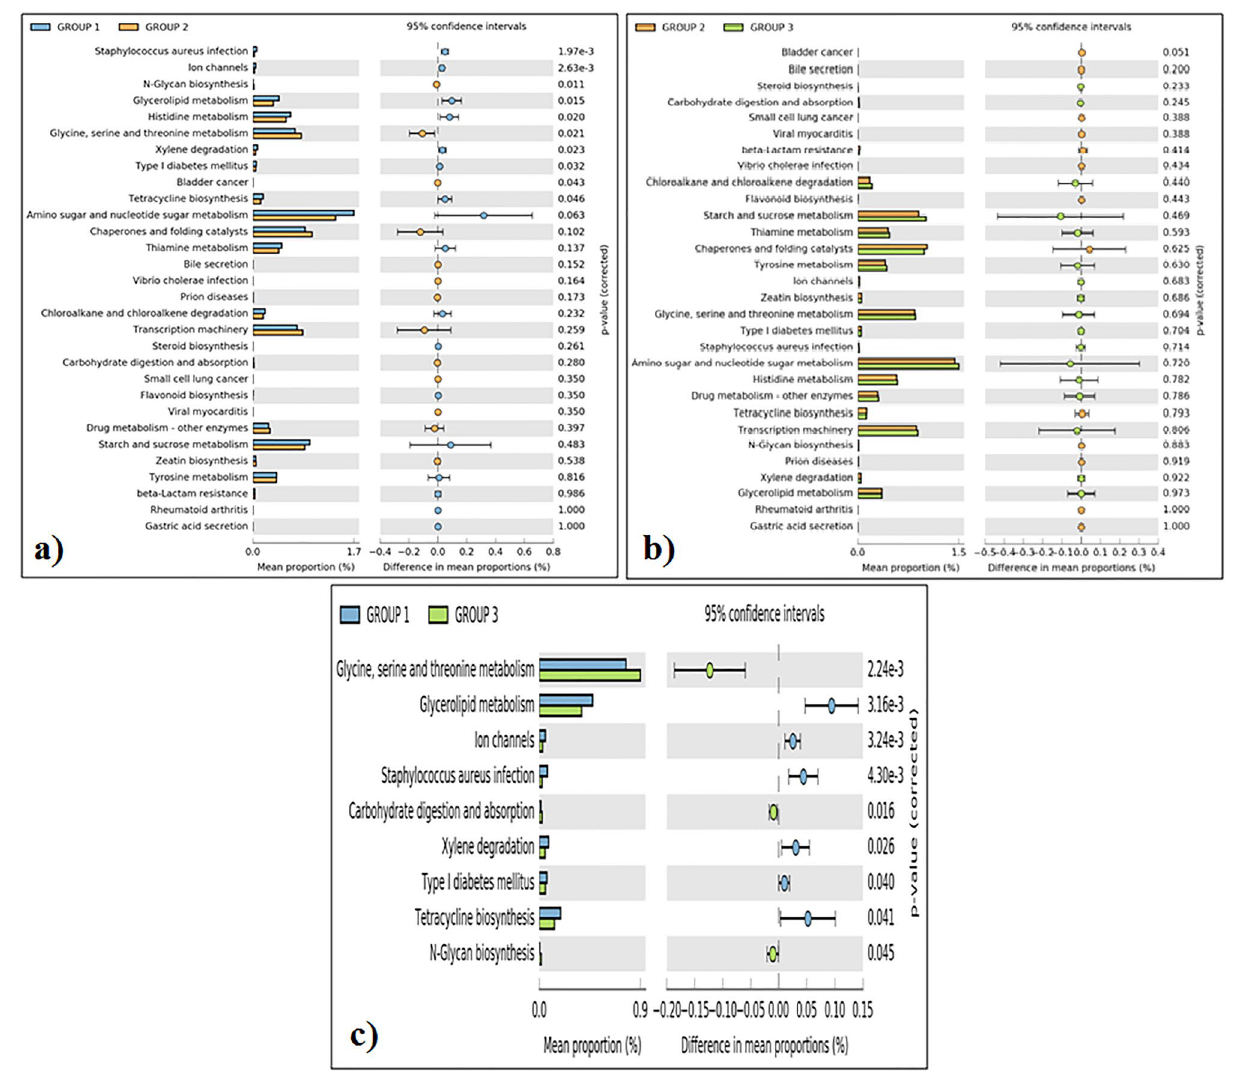
Figure 6. Relative abundances of genes related to different selected function amongst the tribal people ( a ), Adi tribe and Apatani tribe; ( b ) Apatani tribe and Nyshi tribe; ( c ) Adi tribe and Nyshi tribe (Group 1: Adi tribe, Group 2: Apatani tribe, Group3: Nyshi tribe). The significant differences observed between the three groups at 95% confidence level and p < 0.05 are